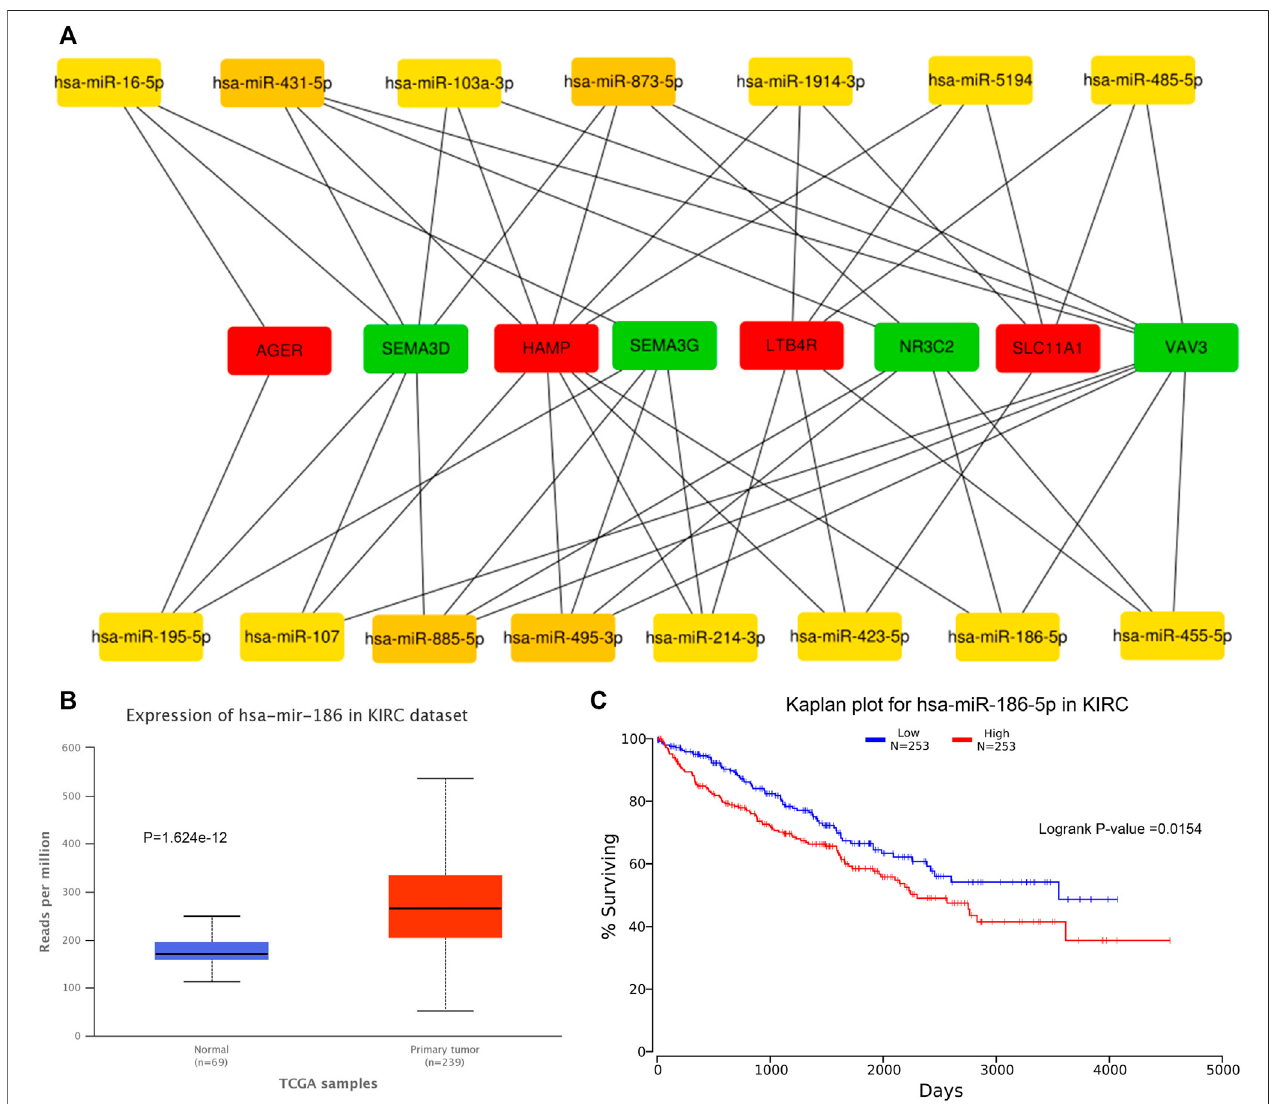
FIGURE6| PredictionofhubmiRNA. (A) Network oftop15miRNA and 8hubgenes. (B) hsa-miR-186-5p expressed higher inthetumor tissue than inthenormal tissue. p (cid:1) 1.624e-12. (C) High hsa-miR-186-5p expression group showed poorer OS. p (cid:1)